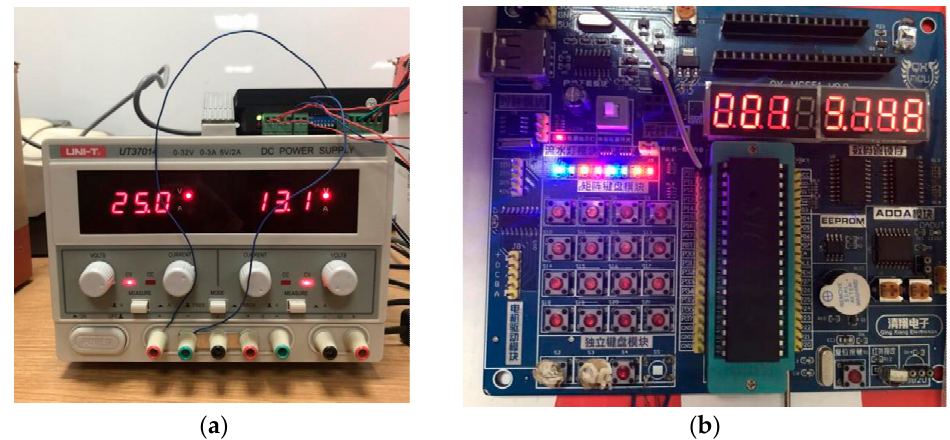
Figure 5. Photos of the control part of the experimental device. ( a ) DC power supply. ( b ) Single chip